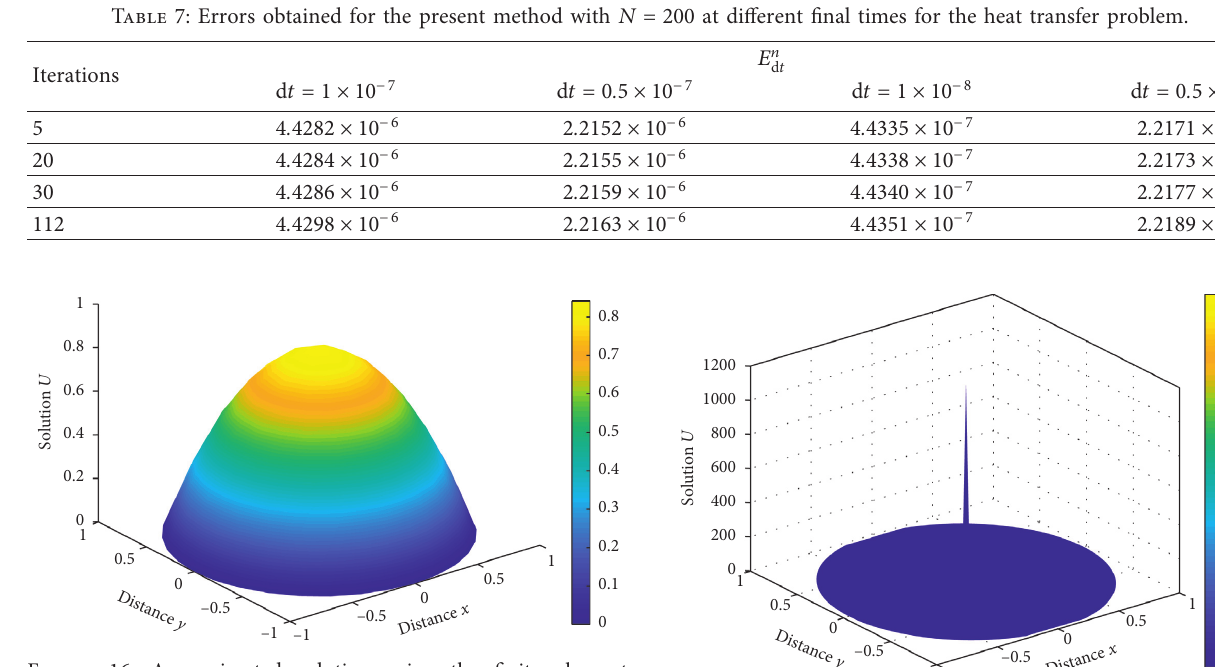
Figure 16: Approximated solution using the finite element method.